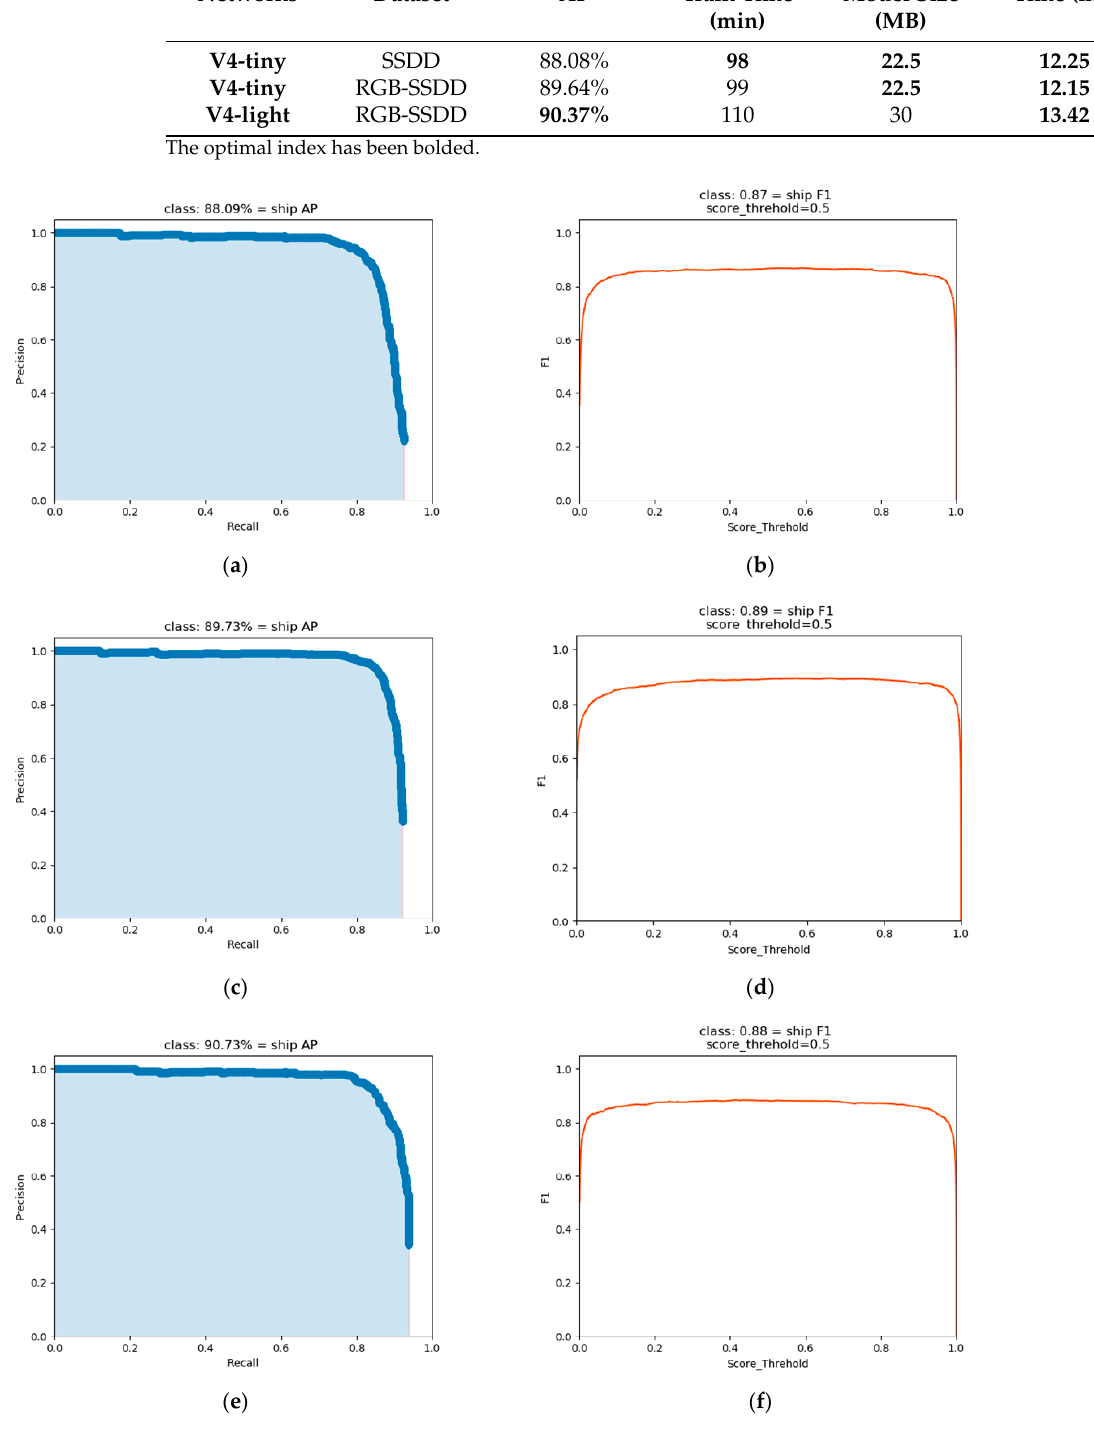
Figure 10. Graphs of performance indicator results of some experiments. ( a – b ) YOLO-V4-tiny on SSDD ( c – d ) YOLO-V4-tiny on RGB-SSDD ( e – f ) YOLO-V4-light on RGB-SSDD.